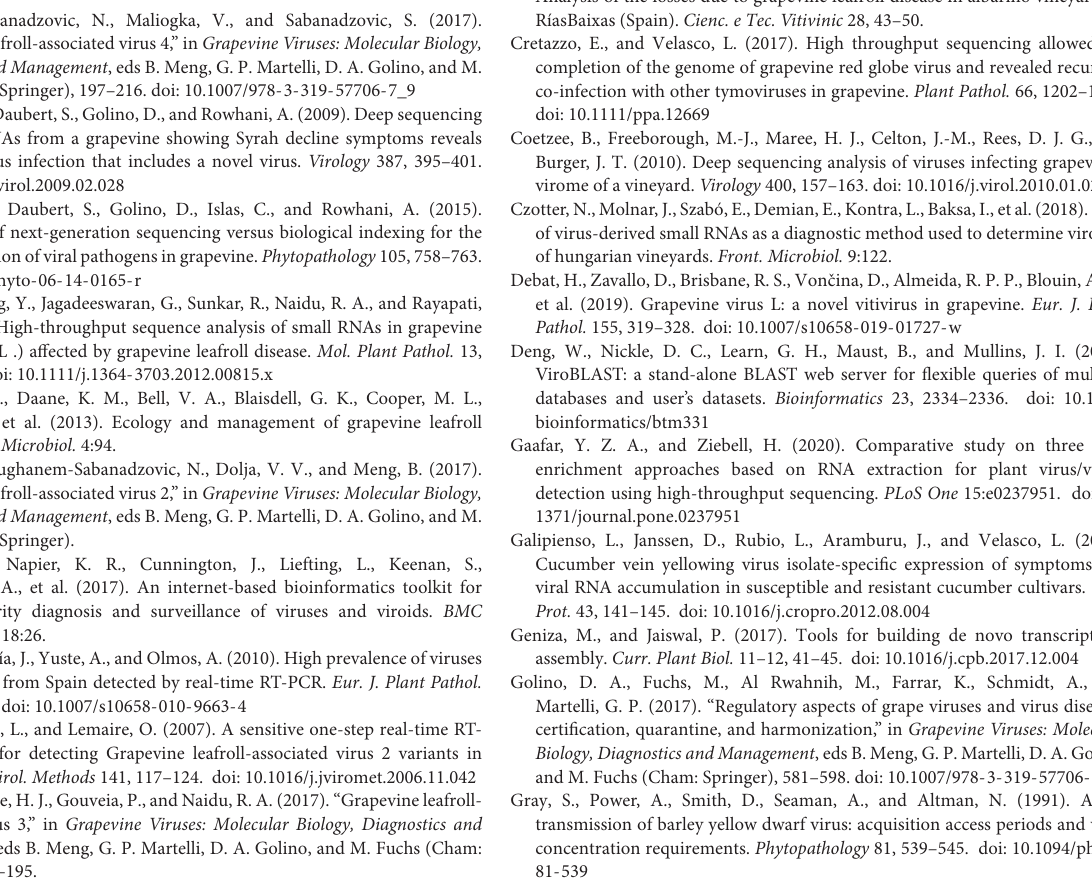
GLRaV-2 variant PN, and GLRaV-3 group II. Reads belong to samples 29170 (GLRaV-1; GLRaV-2 95/933), 32024 (GLRaV-2 PN), and 33116 (GLRaV-3). Reads below the x -axes represent the vsiRNAs aligning to the negative strand of the viral genomes. For the analysis, vsiRNA populations were aligned to the indexed genomes and the BAM alignment file produced was processed using MISIS (Seguin et al., 2016). The genomes are not to the same scale. Supplementary Table 1 | Data of trimmed Illumina reads from the grapevine small RNAs.